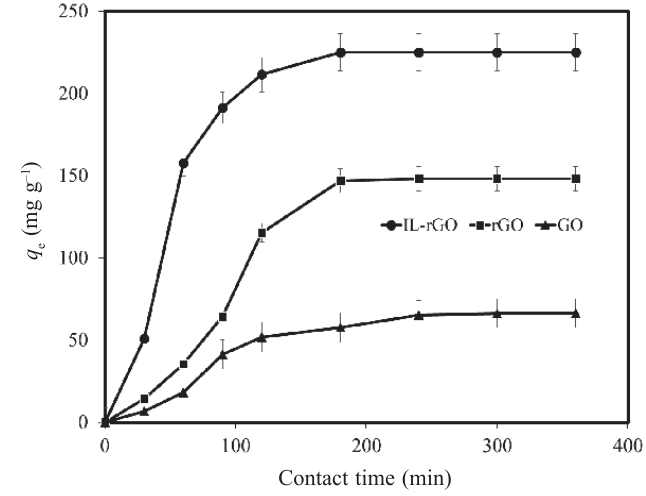
Fig. 5- Fig. 5 – Effect of contact time on the sorption of Cr(VI) on IL-rGO, rGO, and GO (agitation speed = 250 rpm, [Cr(VI)] = 200 mg L –1 , sorbent dosage = 0.5 g L –1 , temperature = 298 K and pH 4.0)